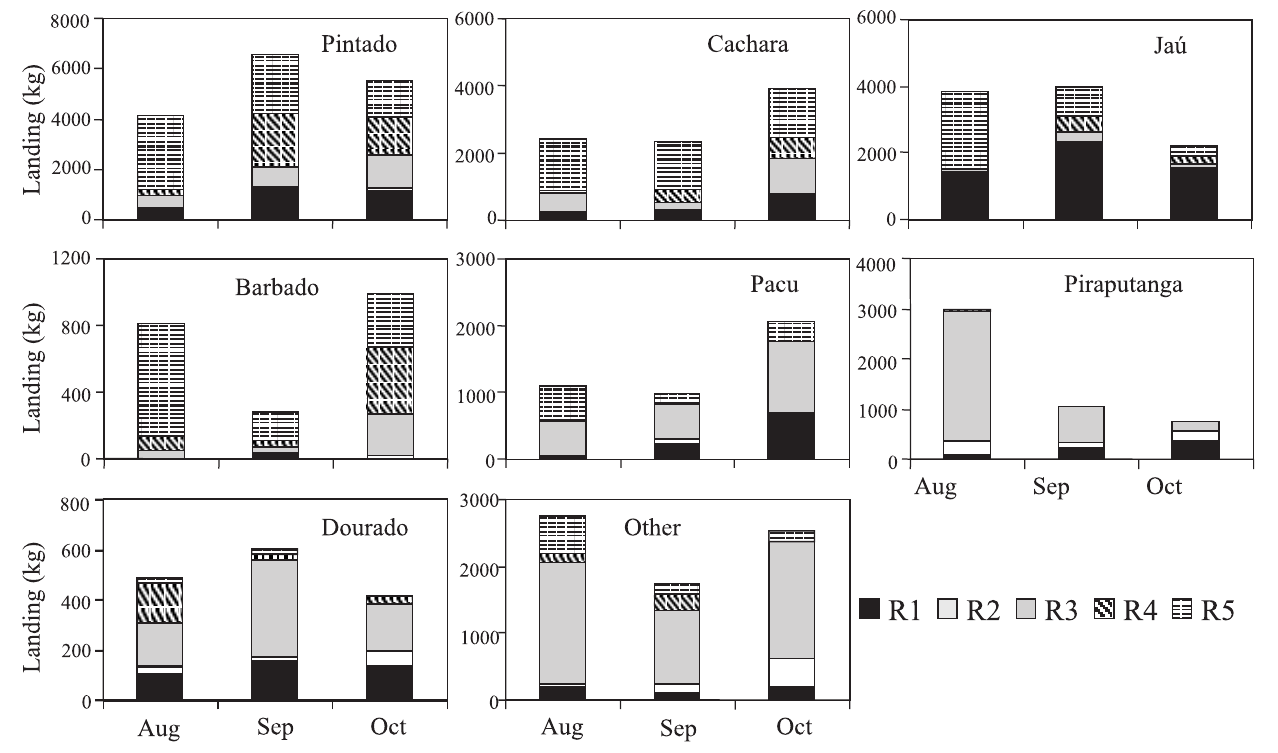
Fig. 5. Landing by species and region of the rio Cuiabá in